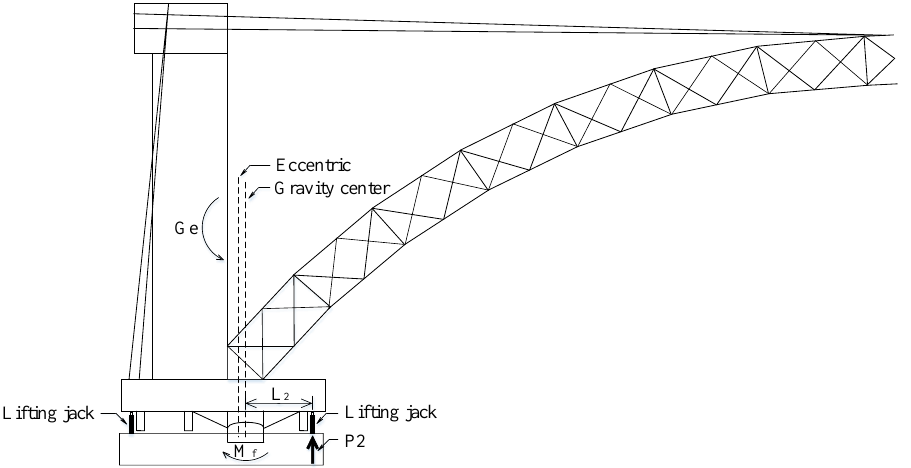
Figure 8. Lifting force on the right side of the rotating system.